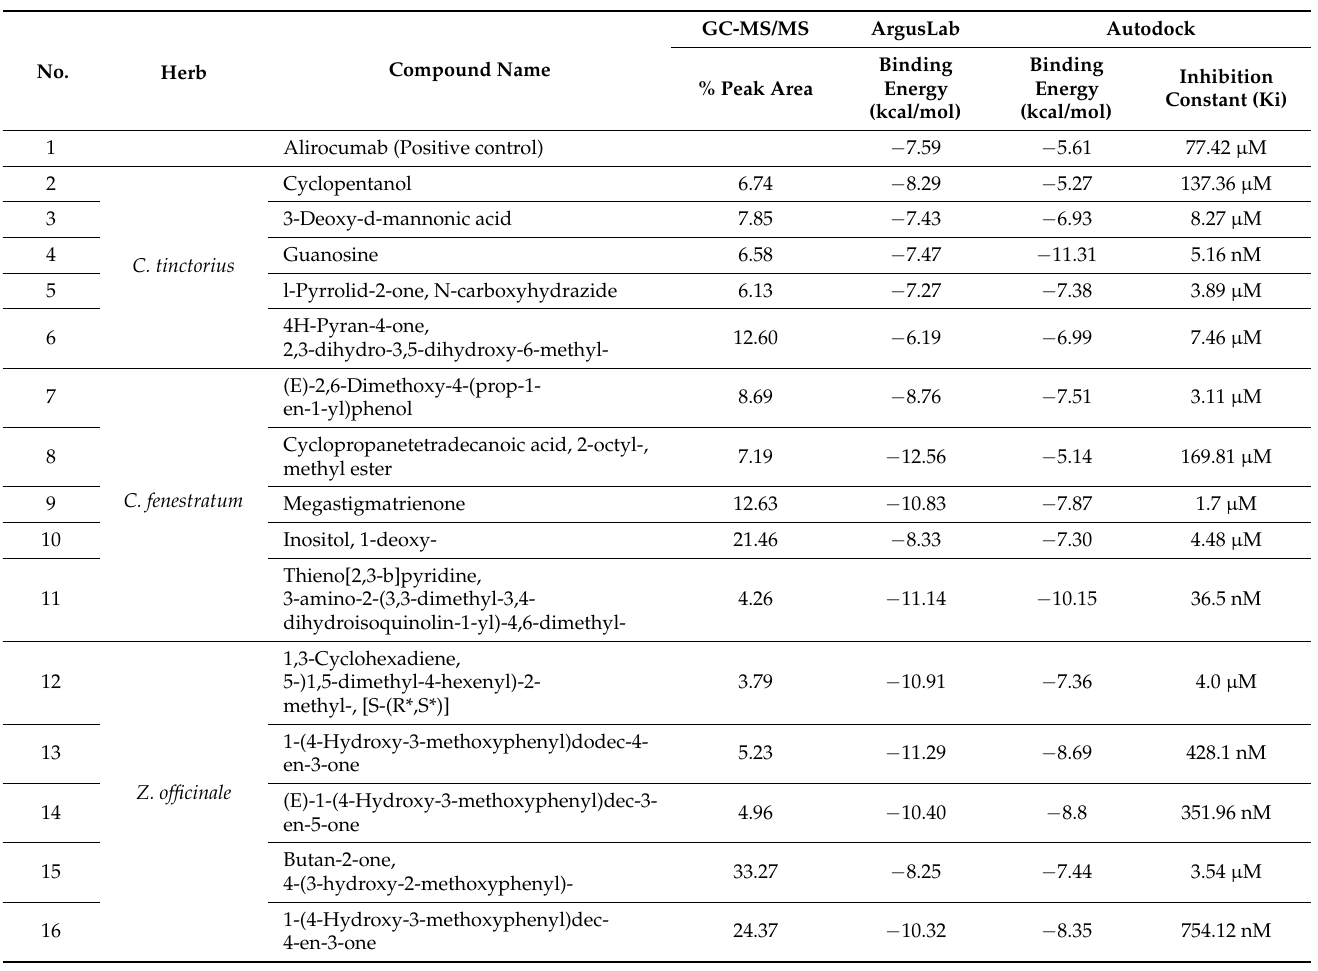
Table 12. Energy binding and phytochemical inhibition constants of herbal extracts with ethanol at the binding sites of PCSK9 from ArgusLab and Autodock analysis and quantification of each compound through GC-MS/MS analysis.